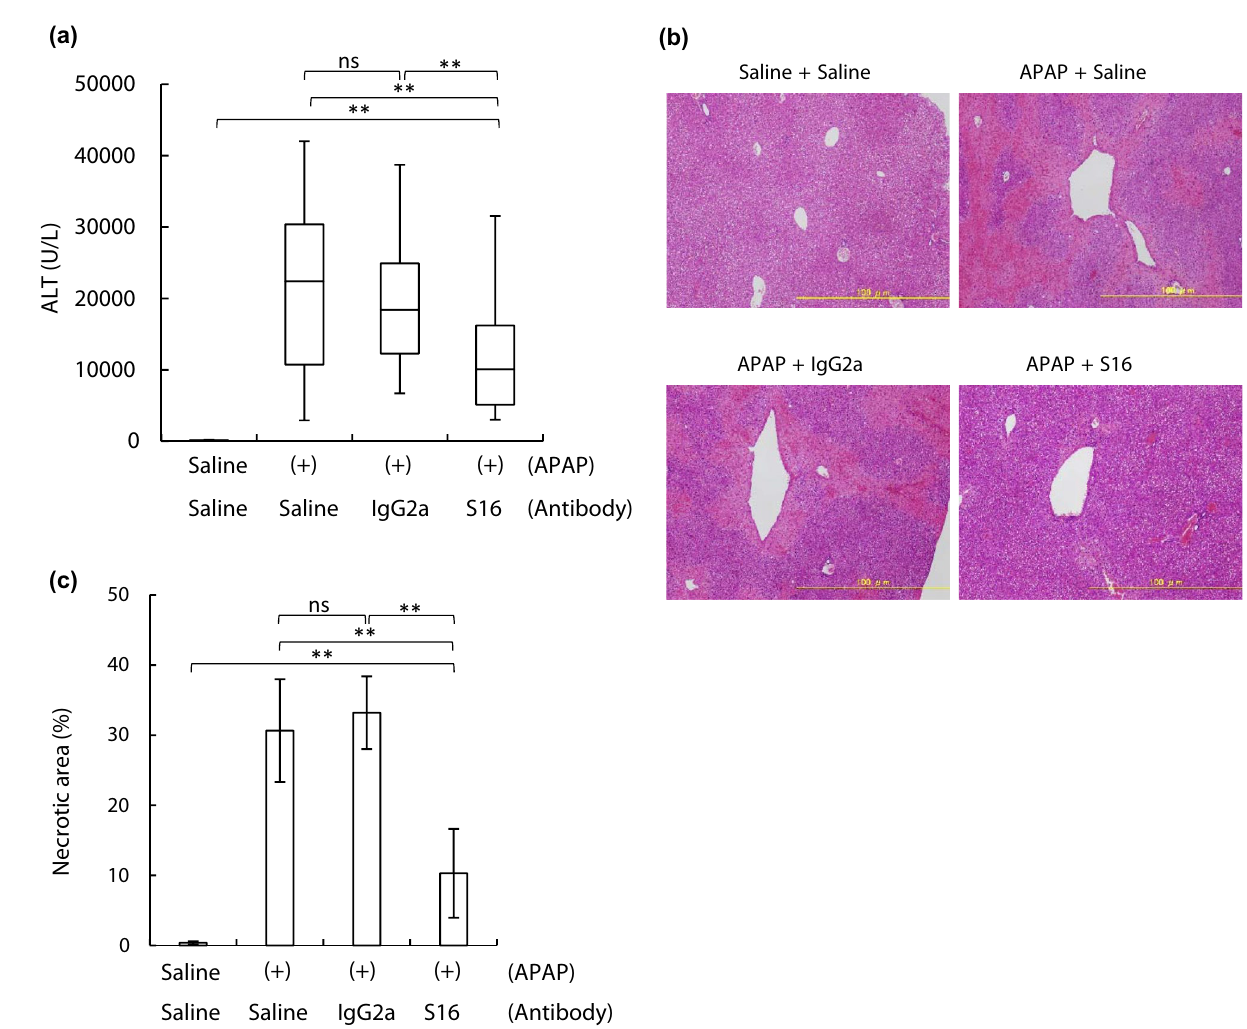
Figure 8. Effect of S16 on APAP-induced hepatotoxicity in mice. APAP (300 mg/kg) was intraperitoneally administered to BALB/c mice (7-week-old, female, n = 13, in each group). After 4 h of APAP treatment, the mice were injected with saline, IgG2a (100 μg), or S16 (100 μg). ( a ) ALT was quantified in the serum of APAP- administered mice after 28 h. ALT levels are expressed as median values with interquartile ranges from three independent experiments. ( b ) Hepatic histology following APAP administration were examined using H&E staining. The livers of normal mice (upper left) and APAP-administered mice injected with saline (upper right), IgG2a (lower left), or S16 (lower right) were harvested from five different mice. Images are representative of each treated mouse. Scale bar = 100 μm. ( c ) Necrotic areas in each H&E-stained section (shown in b ) was quantified using the BZ-X analyzer. Data of the necrotic area are shown using the mean ± SD from five mice. In ( a ) and ( c ), significant differences between the S16 group and other groups are indicated using asterisks (** p < 0.01). ns, no significant differences between the saline group and the IgG2a